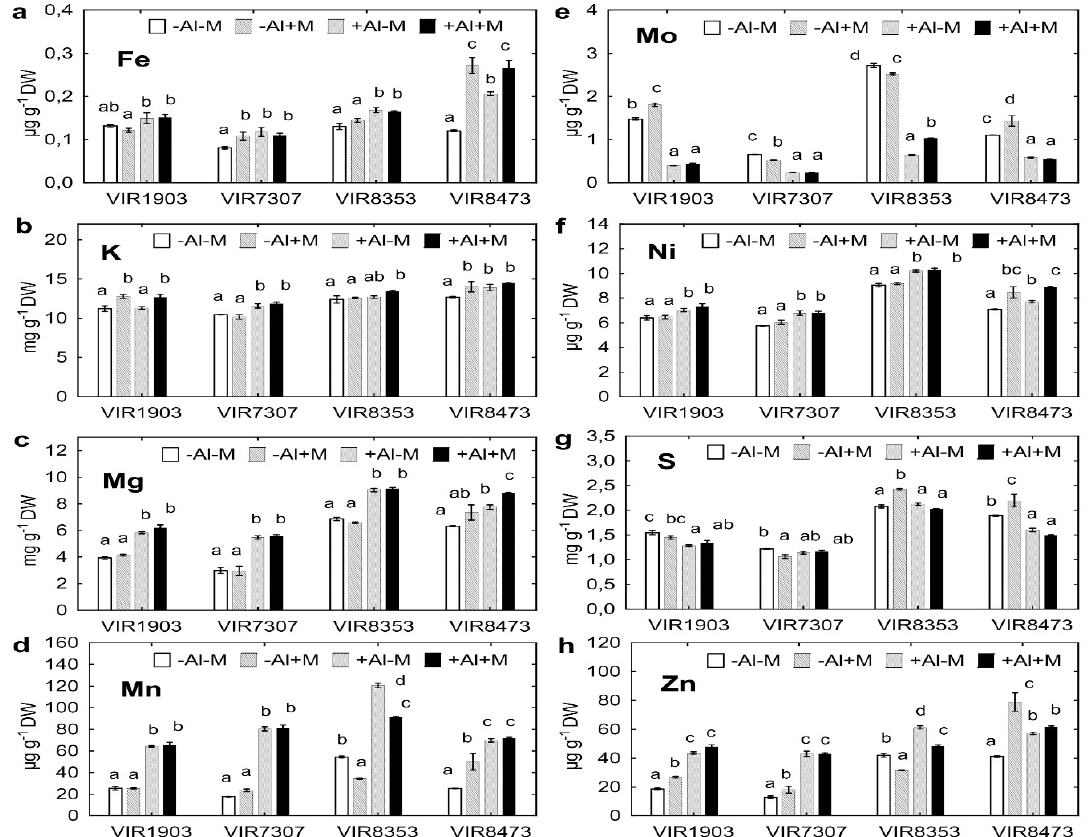
Figure 7. Concentration of nutrients Fe ( a ), K ( b ), Mg ( c ), Mn ( d ), Mo ( e ), Ni ( f ), S ( g ) and Zn ( h ) in shoots of pea genotypes VIR1903, VIR7307, VIR8353 and VIR8473 inoculated with microbial consortium. See details in the legend to Figure